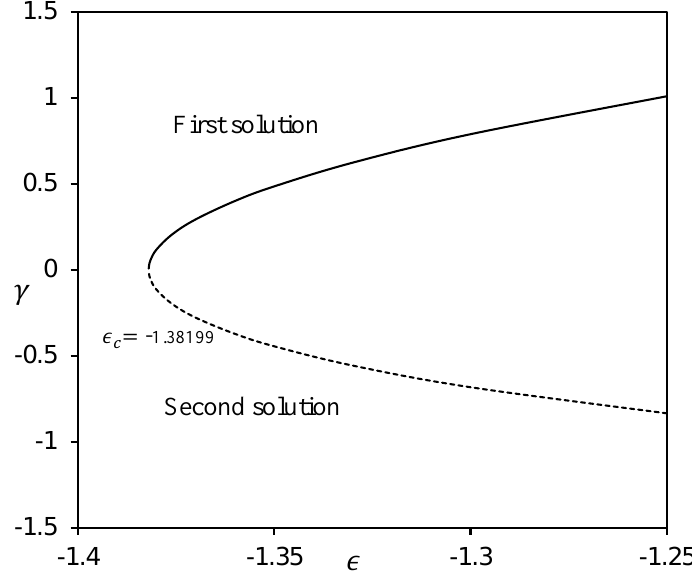
Figure 10. Smallest eigenvalues γ for different values of ε when Pr = 6.2, Nb = 0.3, Nt = 0.1, Rd = 0.1, θ w = 0.3, Le = 3, Bi = 1, M = 0.1 and s = 0.1.